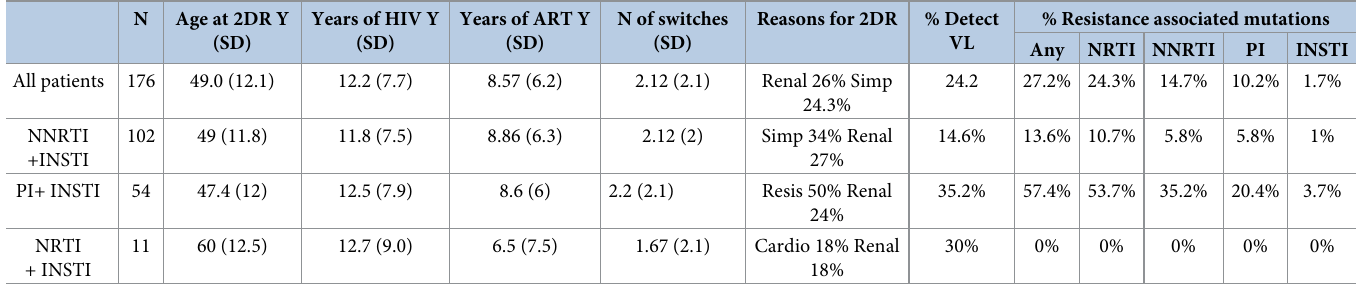
Table 4. 2DR regimens- patients characteristics and resistance